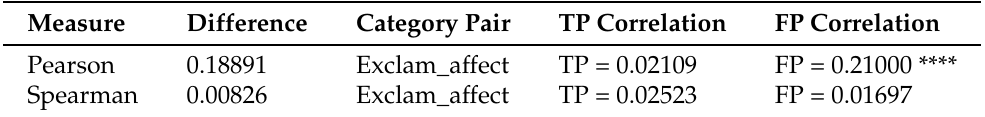
Table 48. Exclamations and Affect in